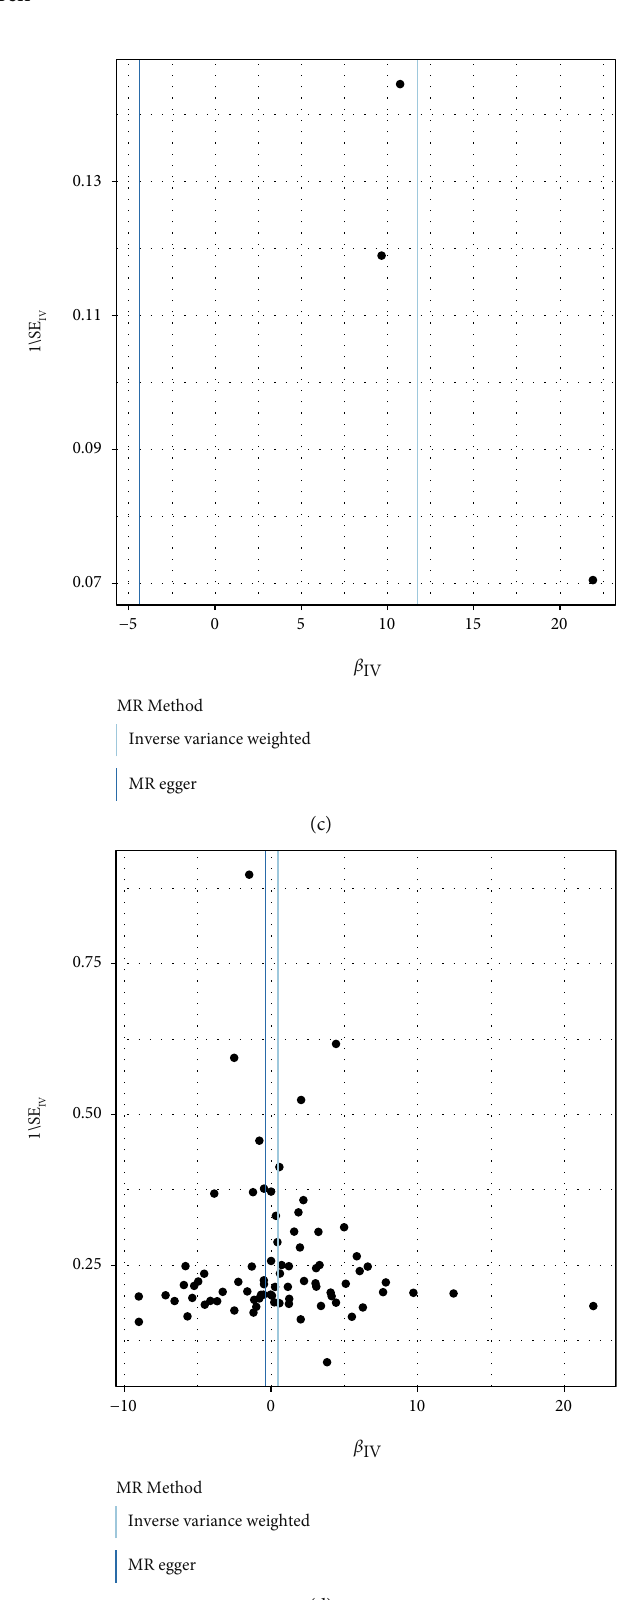
Figure 3: Funnel plots for the causal associations of FSH, TSH, hyperthyroidism, and hypothyroidism with risk of venous thromboembolism. (a) FSH, (b) TSH, (c) hyperthyroidism, and (d) hypothyroidism. Abbreviations: TSH: